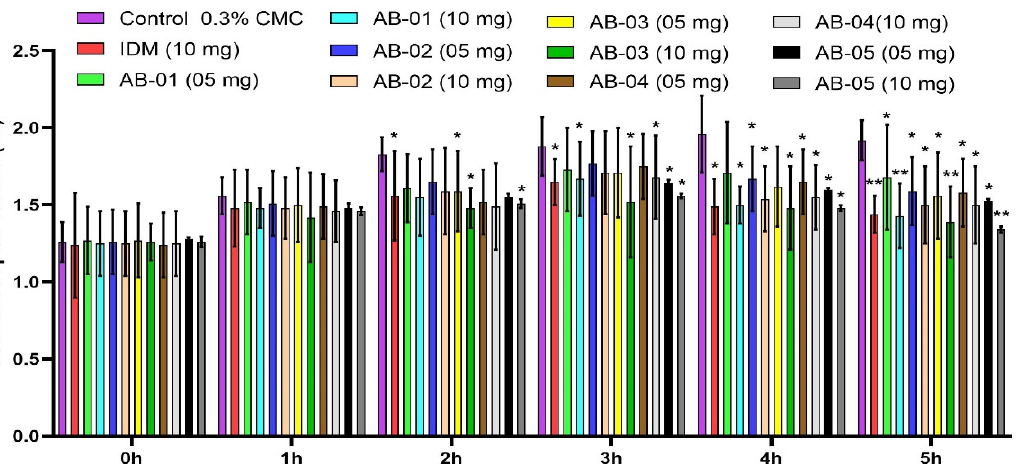
Figure 1. Effect of isolated compounds AB-01, AB-02, AB-03, AB-04 and AB-05 and Indomethacin (IDM) on carrageenan-induced rat paw edema. Each value is expressed in Mean ± S.E.M. one-way ANOVA followed by Dunnett’s test, p : * p < 0.05 and ** p < 0.01, compared with respective control group.